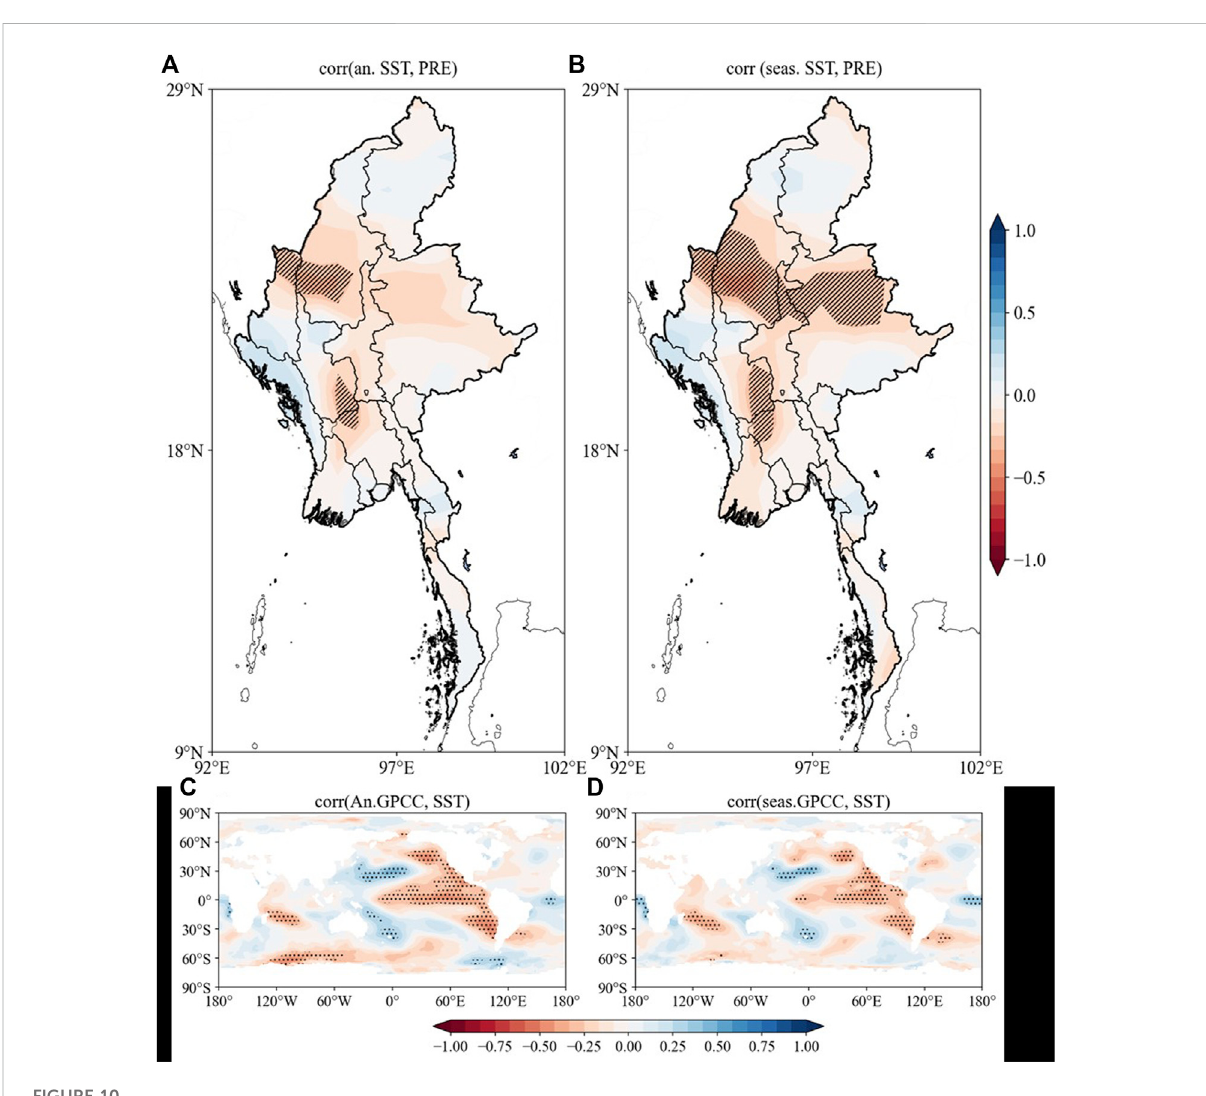
FIGURE 10 Spatial distributions of (A,C) correlation coef fi cients of GPCC PRE (i.e., annual and seasonal) and SST during 1970-2014). (A) GPCC-annual (B) Region GPCC-annual (C) GPCC -seasonal and (D) Region GPCC -seasonal. Hatched area indicates 95% con fi dence